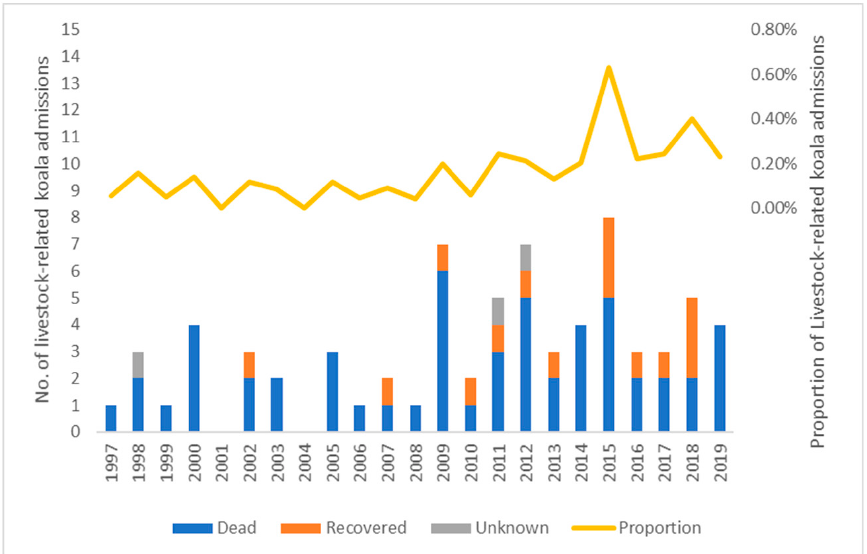
Figure 3. The number of livestock-related koala admissions with their outcomes and proportion of all koala admissions admitted by Queensland wildlife hospitals each year from 1997 to 2019.